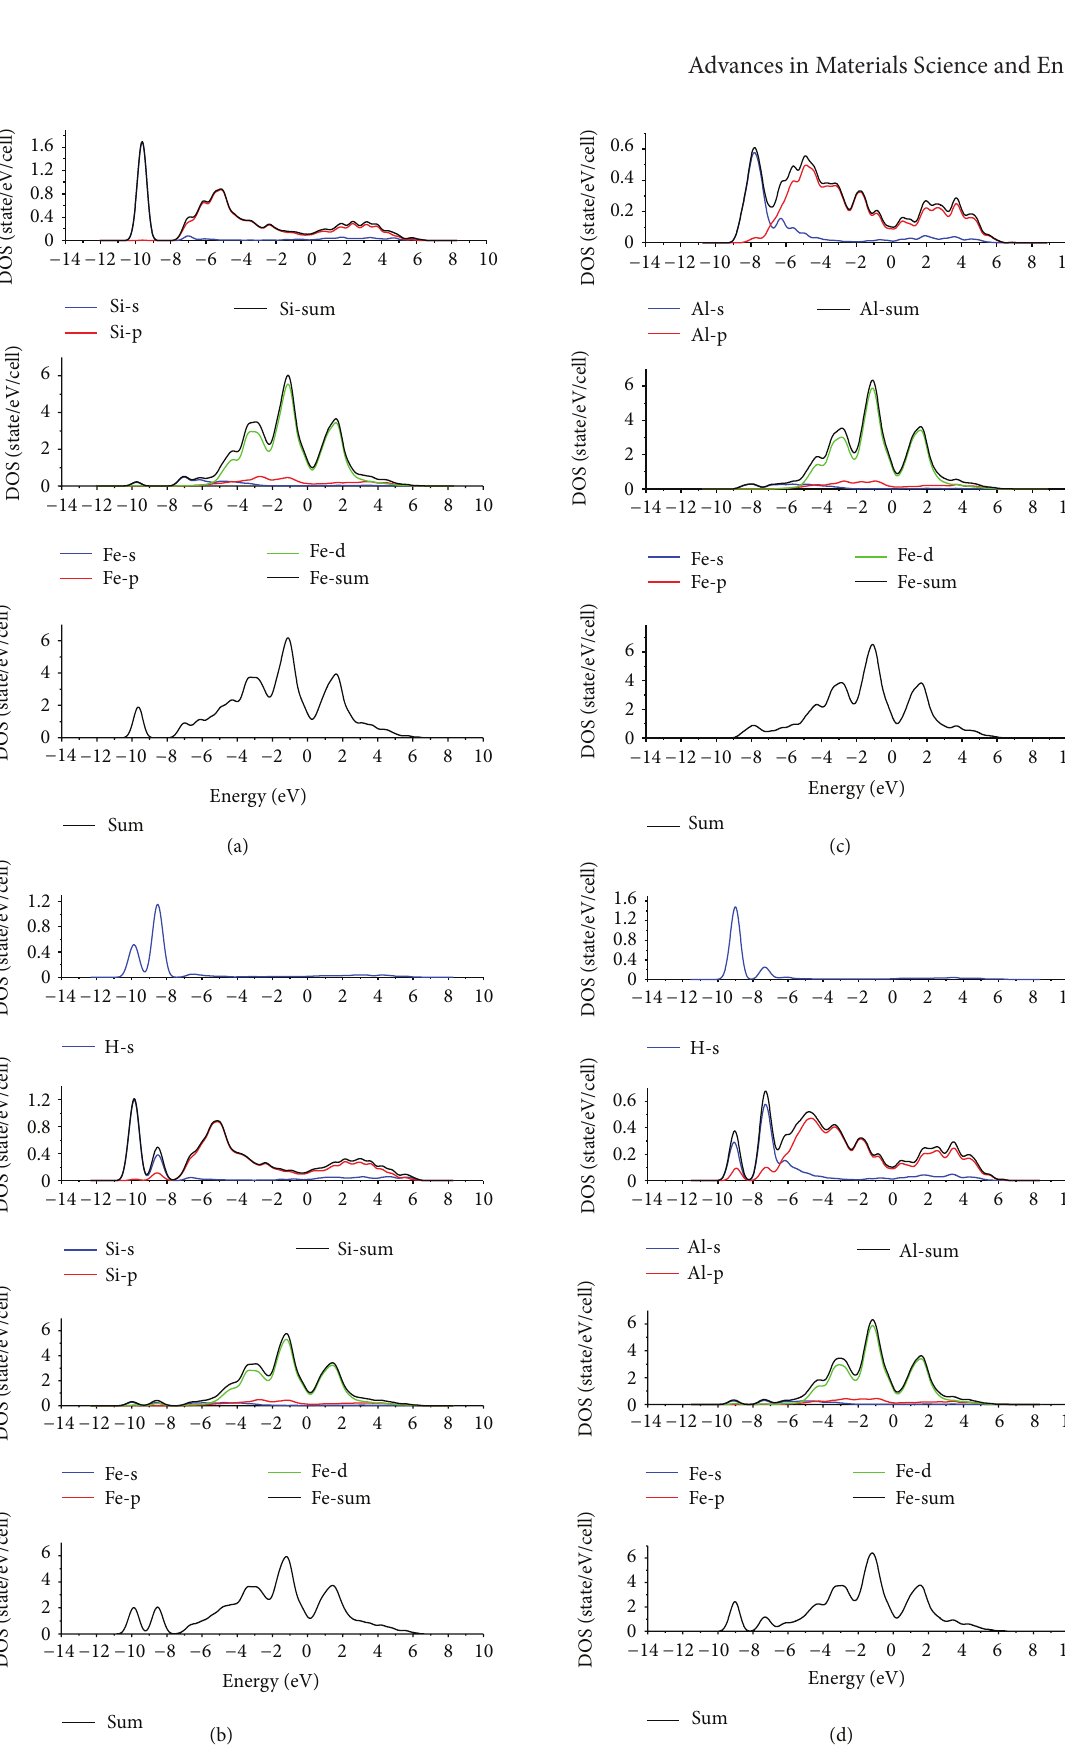
Figure 5: Partial and total density of states. (a) Fe-Si system, (b) Fe-Si-H system, (c) Fe-Al system, and (d) Fe-Al-H